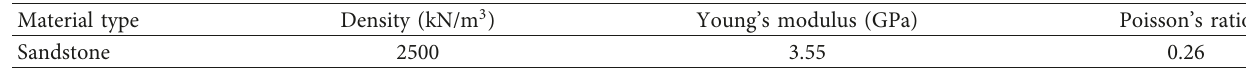
Table 1: Mechanics properties of the intact rock.